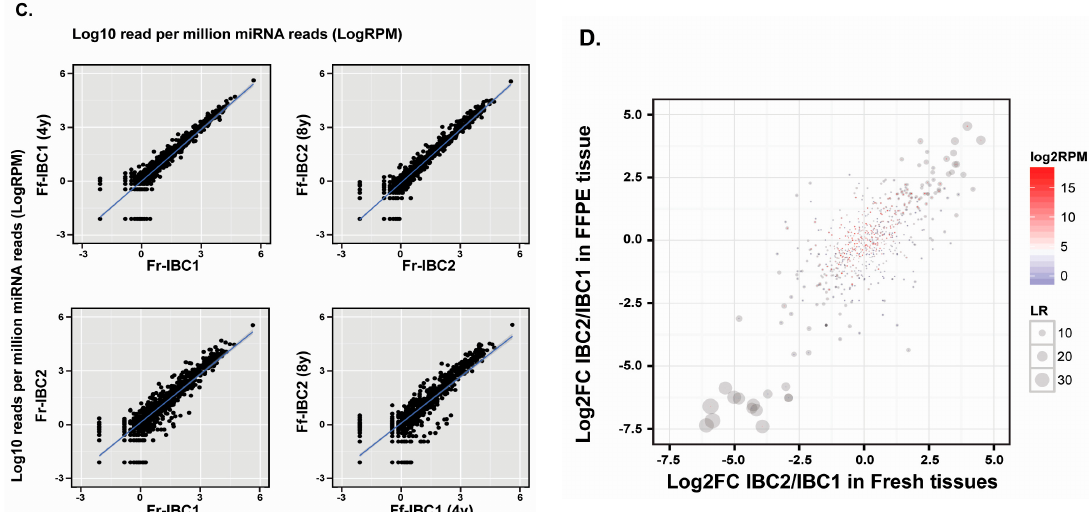
Figure 2. Evaluation of the optimized barcoded cDNA library preparation protocol with matched frozen and FFPE RNA samples. ( A ) Distance mapping of miRNA sequencing expression using the Euclidean distance metric for four pairs of matched frozen and FFPE specimens. Matched frozen (Fr-Cx) and eight-year-old FFPE (Ff-Cx) cervix tissue; matched frozen (Fr-Bngn) and four-year-old FFPE (Ff-Bngn) benign breast tissue; matched frozen (Fr-IBC1) and four-year-old FFPE (Ff-IBC1) invasive ductal carcinoma breast tissue #1; and matched frozen (Fr-IBC1) and eight-year-old FFPE (Ff-IBC2) invasive ductal carcinoma breast tissue #2 were analyzed; ( B ) RNA quality evaluation on a Bioanalyzer total RNA nano chip of matched frozen (Lanes 1 and 2) and FFPE (Lanes 3 and 4) IBC tissue pairs; ( C ) Scatter plot comparisons between matched frozen and FFPE IBC Tissues 1 and 2 (top right and left plots); ( D ) Correlation between IBC2/IBC1 fold-change in matched FFPE and frozen specimens, represented by abundance of miRNAs (log count per million (CPM), red to blue color) and significance of the expression difference between the two tissue pairs (Likelihood Ratio, values above 10 being significant ( p -value < 0.05)), displaying differentially-expressed miRNAs between two breast tumors (invasive ductal carcinomas).